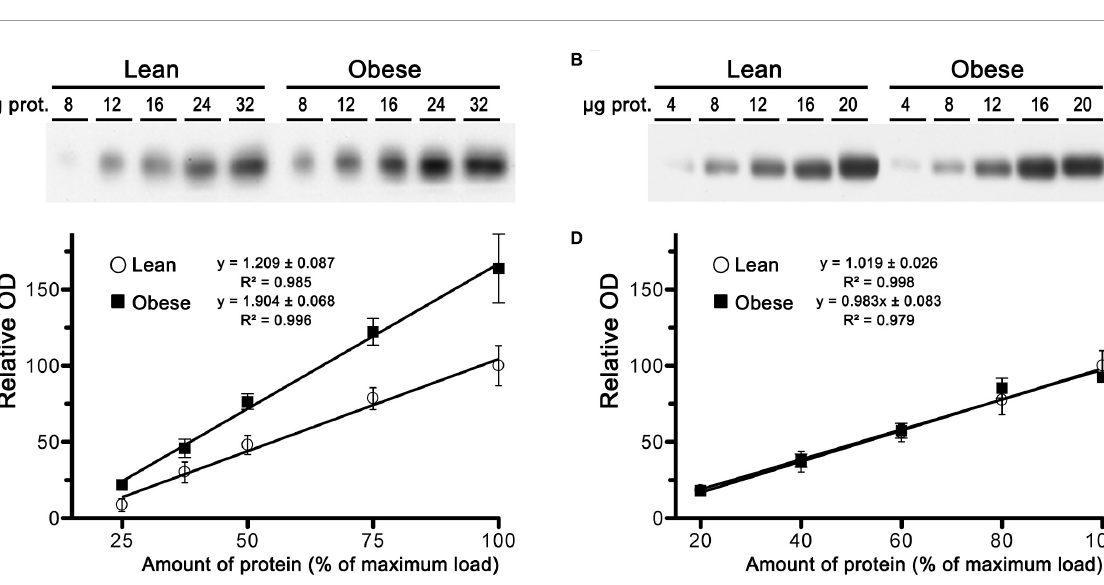
FIGURE6 Expression analysis of CB 1 receptor in samples of crude membranes from medial prefrontal cortex and neocortex of lean and obese Zucker rats. (A,B) Representative images of CB 1 receptor immunoblots using increasing amounts of total protein in crude membranes of mPCx (A) and NCx (B) from lean and obese Zucker rats. (C,D) Linear regression analyses of the relative optical density (OD) measurements of CB 1 -immunoreactivity in crude membranes of mPCx (C) and NCx (D) from lean ( ◦ ) and obese ( • ) Zucker rats. The correlation coefficients are provided. Data presented are means ± SEM of four independent